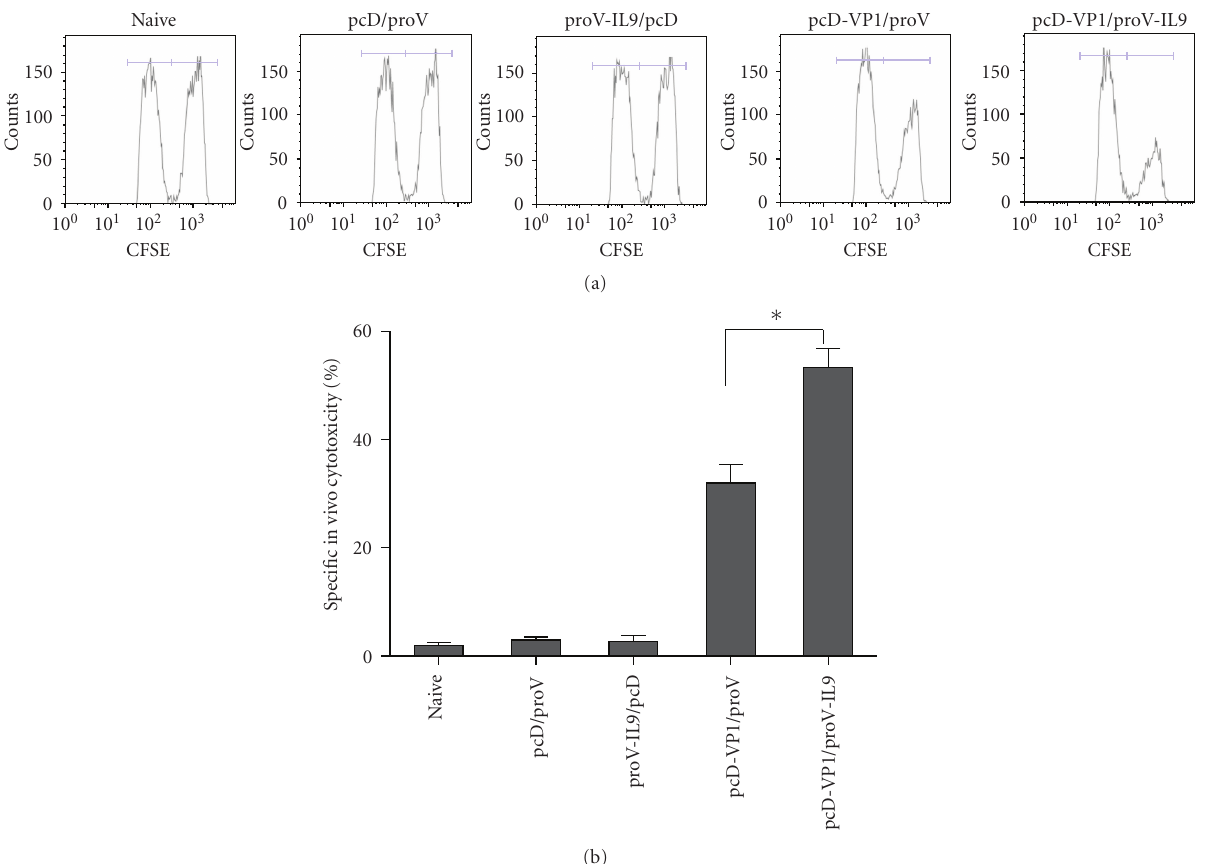
Figure 3: E ff ects of IL-9 on in vivo cytotoxic responses. (a) To analyze e ff ect of IL-9 on VP1-specific cytotoxicity, the in vivo cytotoxic assay was performed by comparing the ratio of CSFE high of target cells versus CSFE low of controls after in vivo transfer into immunized mice by FACS. (b) The percentage of specific lysis is summarized in the means of the three independent experiments. ∗∗ indicates P < . 01 between